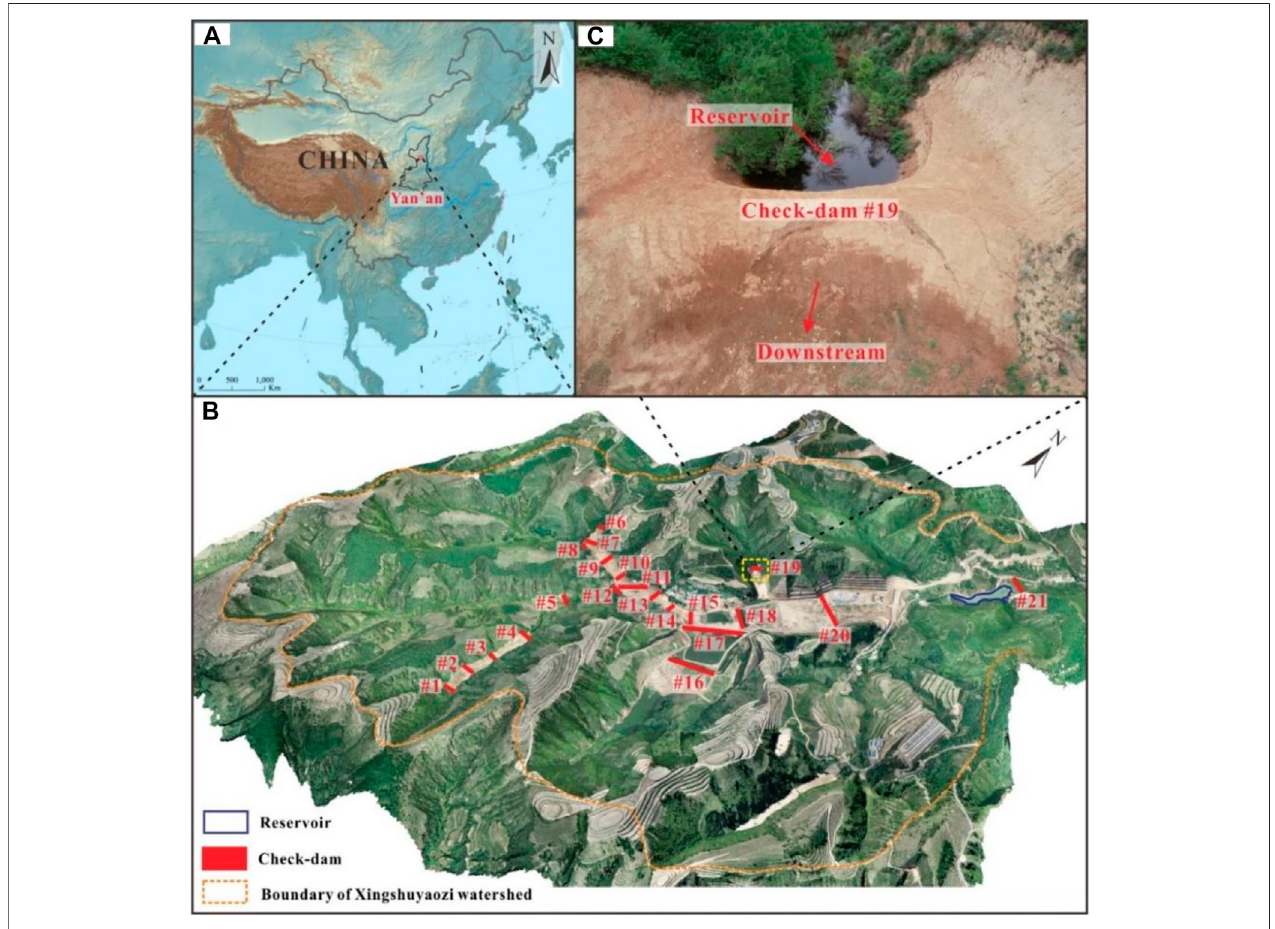
FIGURE 1 | Location of research area and studying check dam. (A) Research location, (B) remote sensing image of research watershed based on UAV, and (C) research check dam.